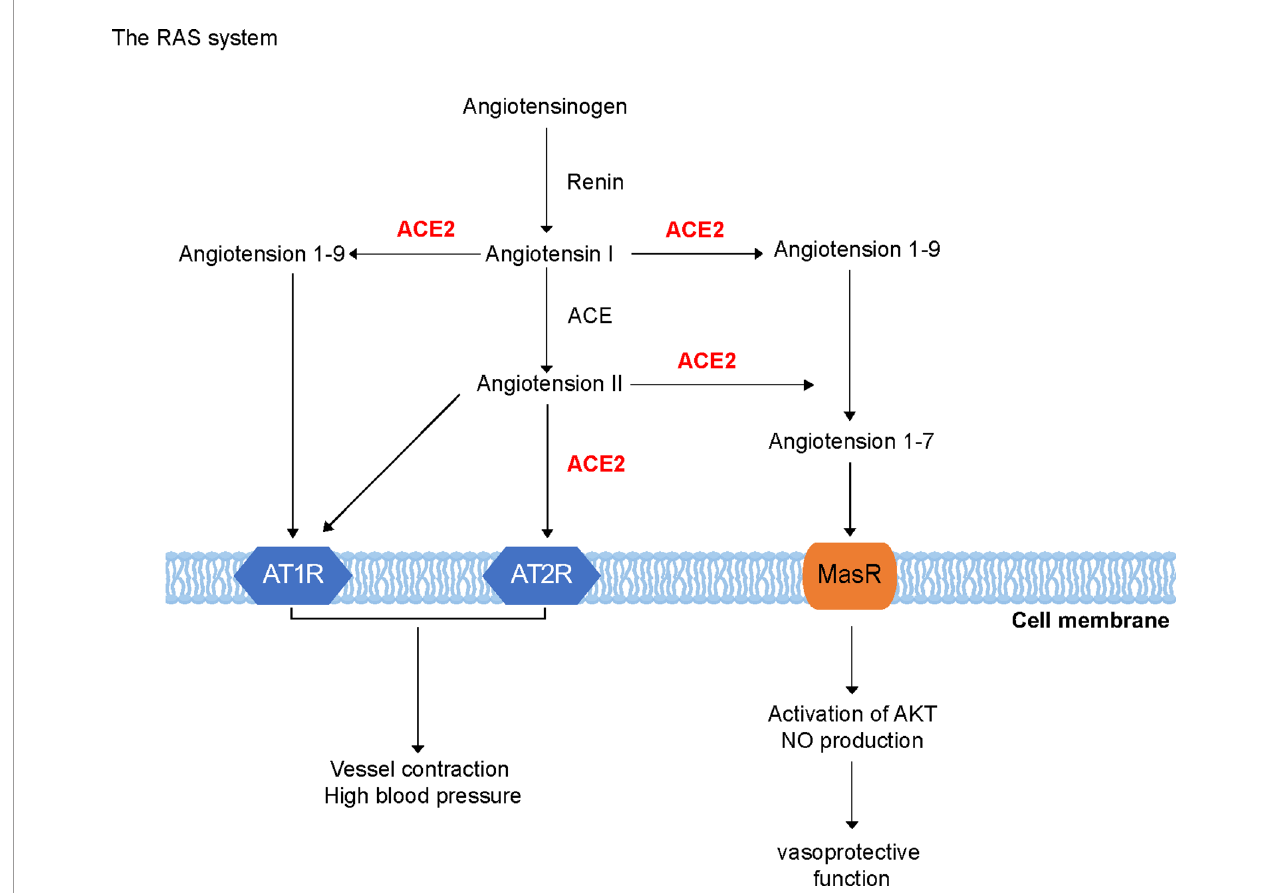
FIGURE 1 | Renin – angiotensin system. Renin cleaves angiotensinogen to form Ang I, which is then cleaved by angiotensin-converting enzyme (ACE) to generate Ang II. Ang II can bind to Ang II type 1 and 2 receptors (AT1/2R). ACE2 is a single transmembrane protein, which can recognize Ang I and cleave it into Ang 1-9, which is quickly converted to Ang 1-7 by ACE. Moreover, Ang-(1-7) has been identi fi ed as a ligand for Mas receptor, which is a seven-transmembrane G-protein coupled receptor. Mas receptor may induce intracellular signaling cascades such as protein kinase B and induction of nitric oxide (NO)